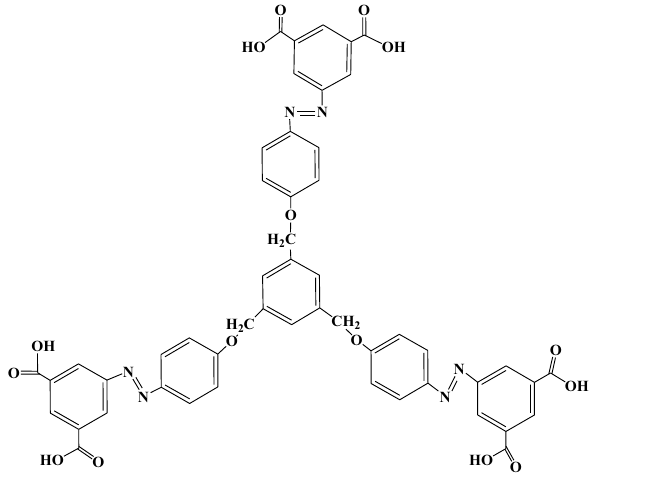
Figure 1. Structure of single molecular TPB.